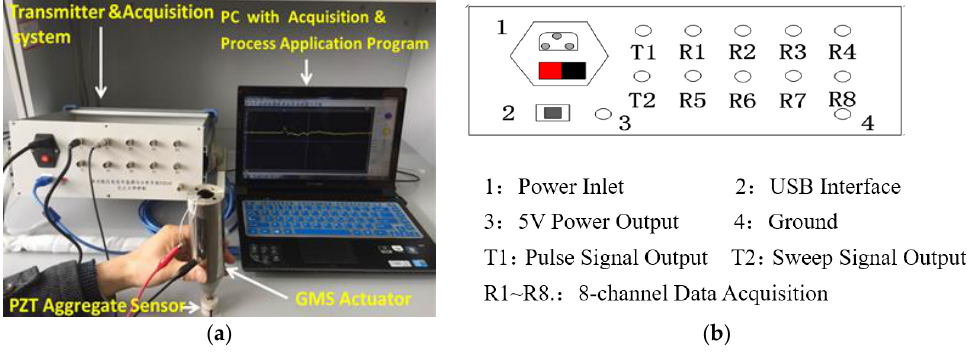
Figure 5. ( a ) Photo of the instrumentation and experimental setup; ( b ) The front panel of the transmission and acquisition system.